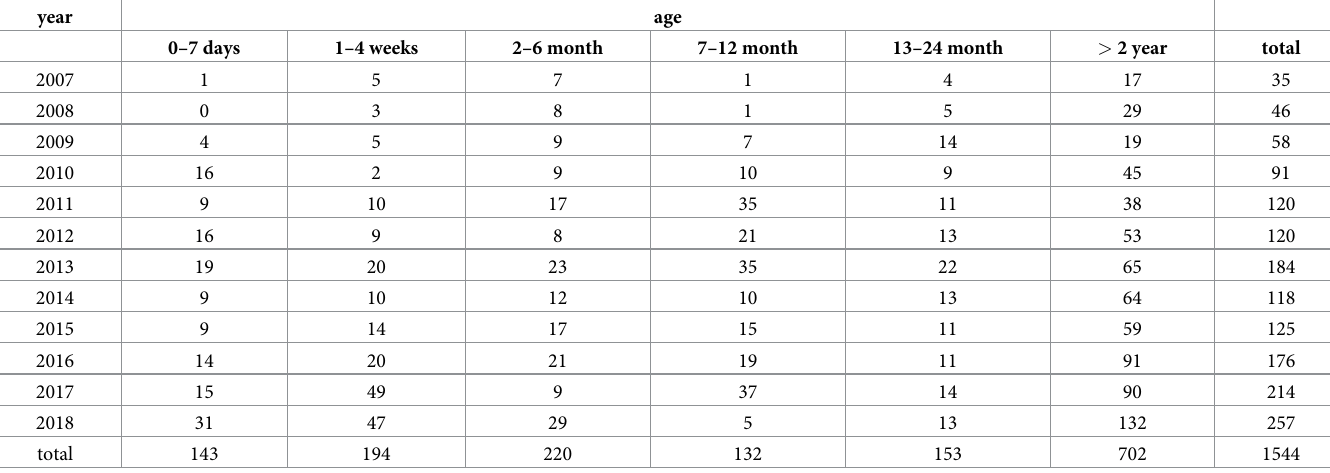
Table 1. Number of livers analyzed for each group categorized per age and